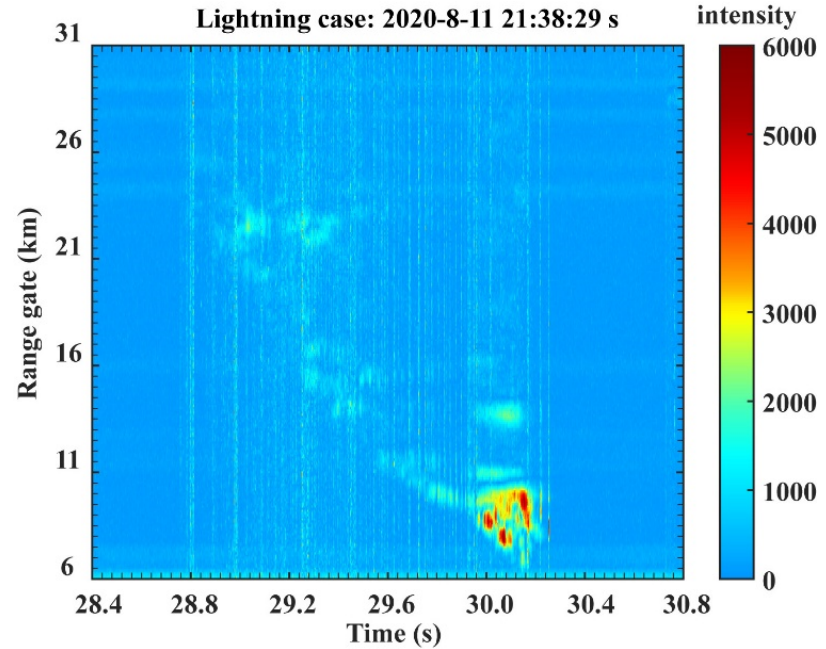
Figure 7. RTI plot of the received lightning echo.